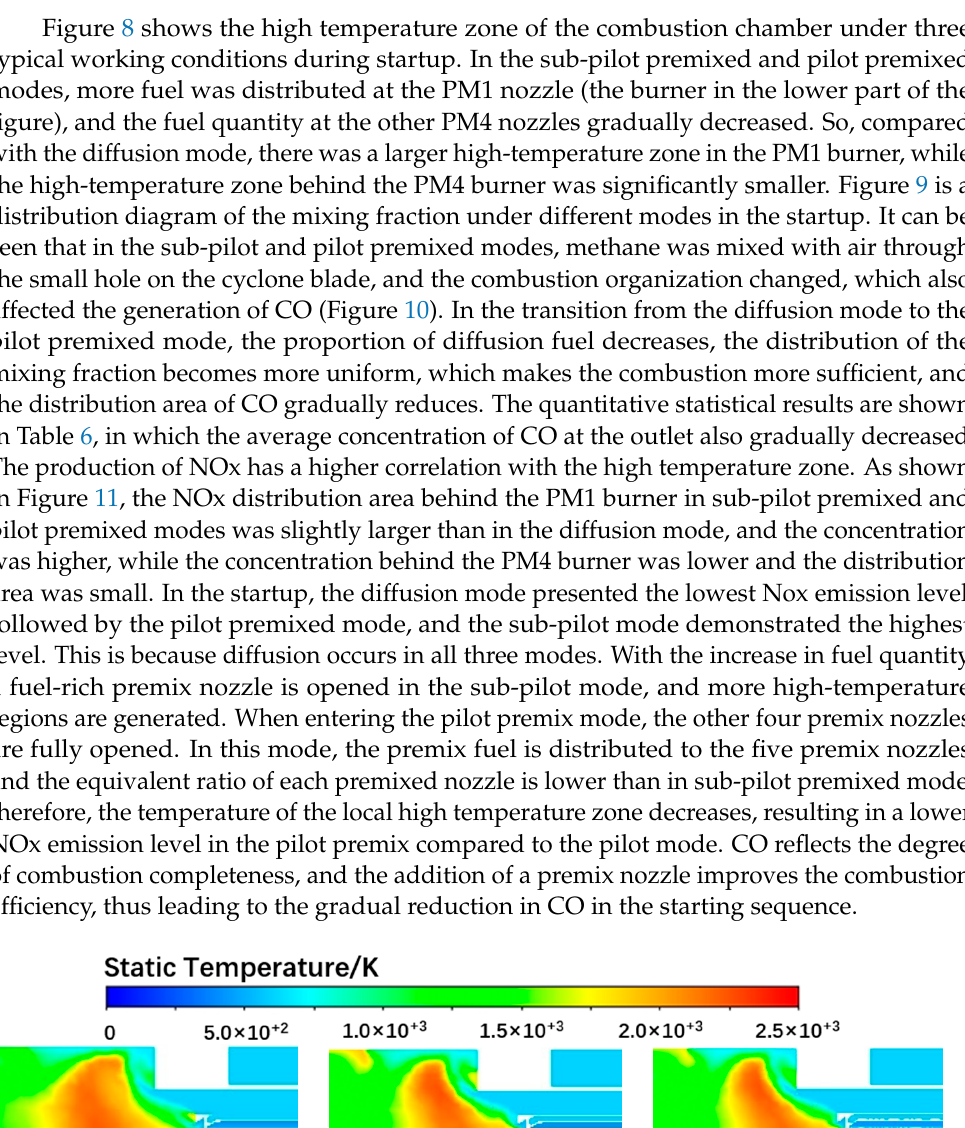
( c ) Figure 9. Calculation results of mean mixture fraction distribution of each mode in startup stage. ( a ) Diffusion; ( b ) Sub-pilot premix; ( c ) Pilot premix. ( a ) ( c ) Figure 10. Calculation results of CO concentration distribution in each mode at startup stage. ( a ) Diffusion; ( b ) Sub-pilot premix; ( c ) Pilot premix.